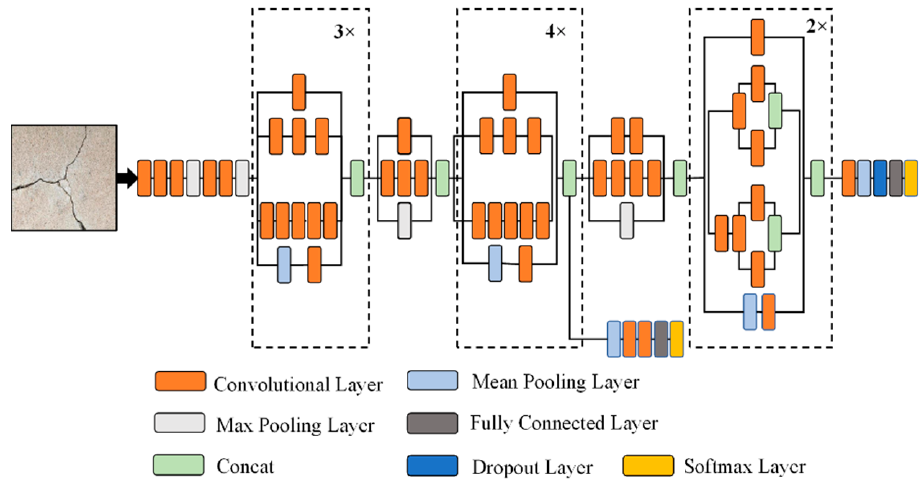
Figure 7. The architecture of Inception-V3 model.